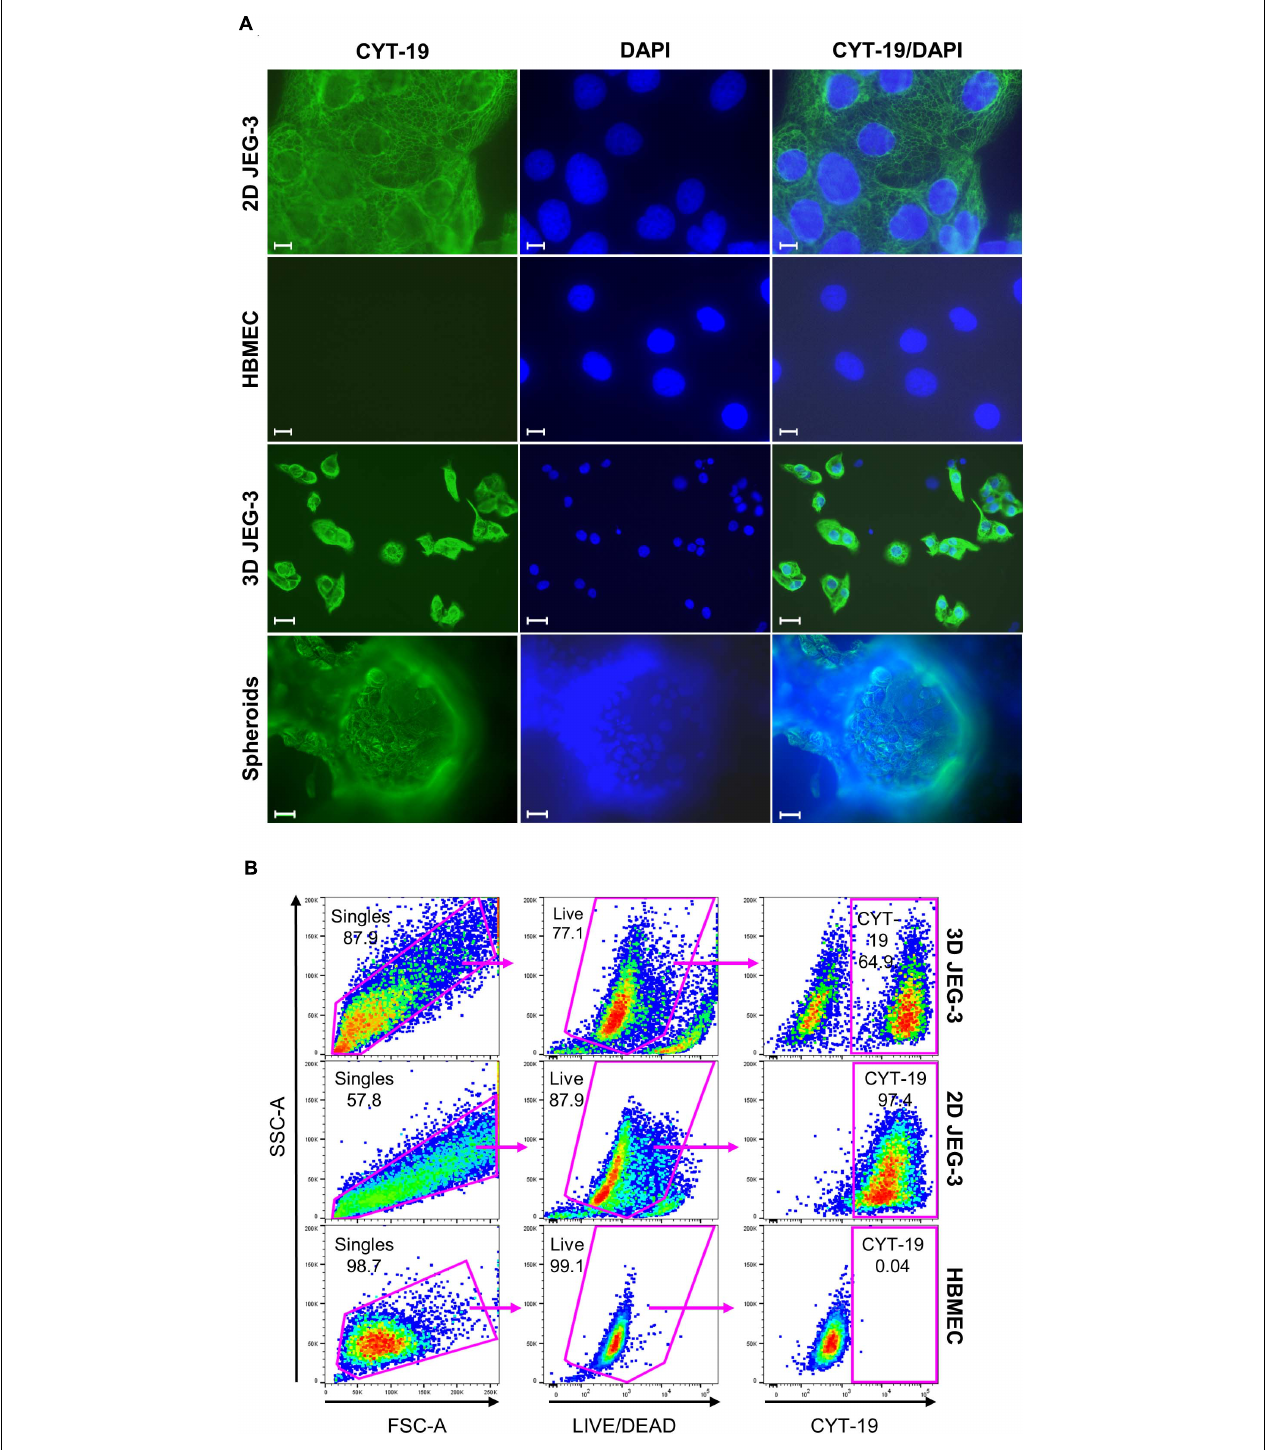
FIGURE 2 | JEG-3 cells but not HBMECs express cytokeratin-19. (A) Immunostaining of 2D JEG-3 cells, HBMECs, 3D-cultured cells detached from beads, and spheroids, as indicated. Cell monolayers and spheroids were fixed/permeabilized and stained with rabbit anti-CYT-19 followed by Alexa Fluor 488 anti-rabbit IgG (H + L) antibodies (green). Slides were mounted with Vectashield mounting medium containing DAPI to visualize nuclei (blue). Fluorescent micrographs were acquired on a Keyene BZ-9000 fluorescence microscope. Scale bars: 10 µ m (2D JEG-3 and HBMEC panels); 30 µ m (3D JEG-3 cells detached from beads and spheroids). (B) Flow cytometry analysis for CYT-19 expression in 3D-cultured cells after detachment from beads, 2D JEG-3 and HBMEC cells, as indicated. Gating scheme to identify singles and exclude dead cells based on LIVE/DEAD TM violet dye staining is shown. Data are representative of two independent experiments.